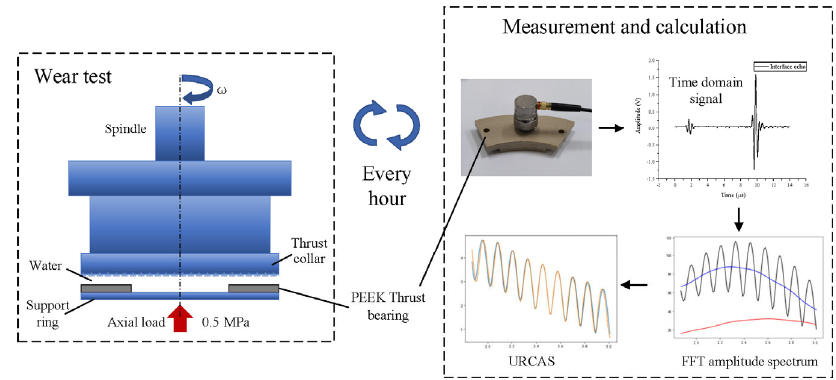
Fig. 22 Test scheme for wear measurement of the bearings.